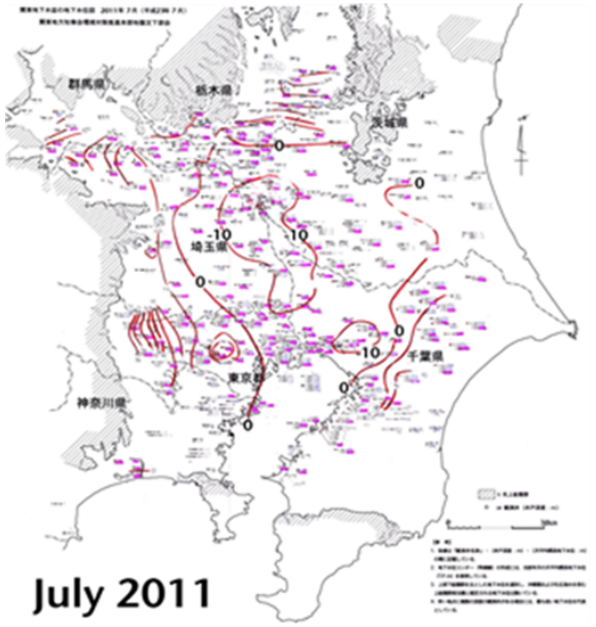
Figure 4. Confined groundwater level in the Kanto groundwater basin (especially the Shiosa sub-groundwater basin). Lowest con- tour line shows 10m below sea level.